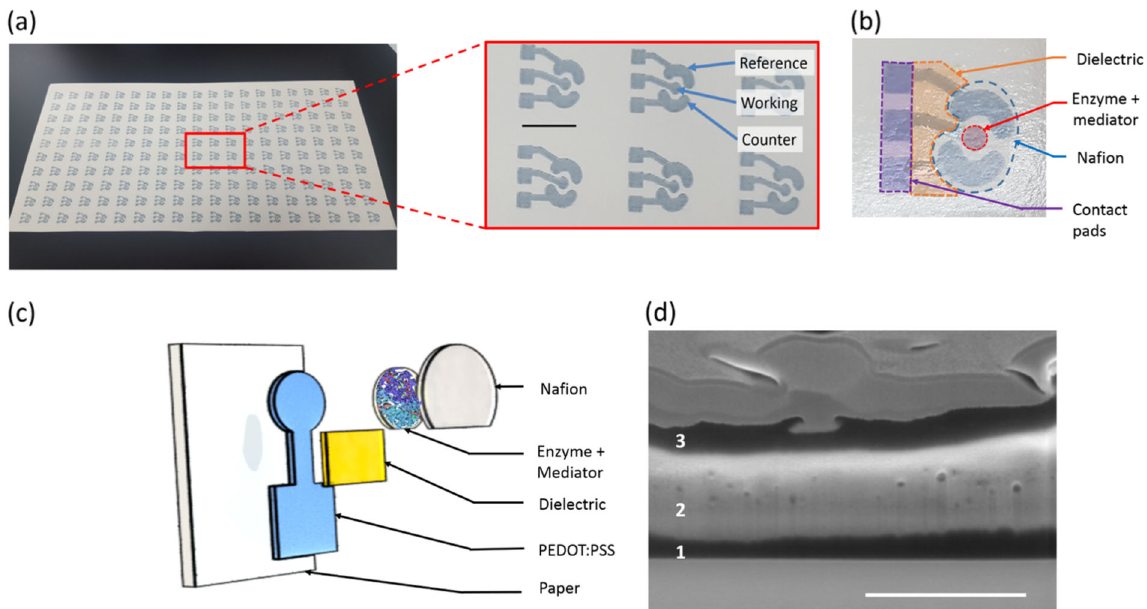
Fig. 1 a Photograph of glucose biosensors inkjet-printed on paper with a loop on the device geometry/con fi guration. The device is comprised of 2 printed layers of PEDOT:PSS used as reference, working and counter electrode. b Photograph of the fully printed biosensor. c 3D exploded schematic of the working electrode with all the separately printed layers, namely the electrode (PEDOT:PSS), the dielectric (SunTronic EMD6415), the biological coating containing the enzyme and the mediator (glucose oxidase and ferrocene), and the encapsulation layer (na fi on). d Cross sectional SEM image of the working electrode taken using a focused ion beam (FIB). PEDOT:PSS (1), the biological coating (2), and the encapsulation layer (3) are assembled vertically on paper. The scale bar in a and d are 1 cm and 1 µm,